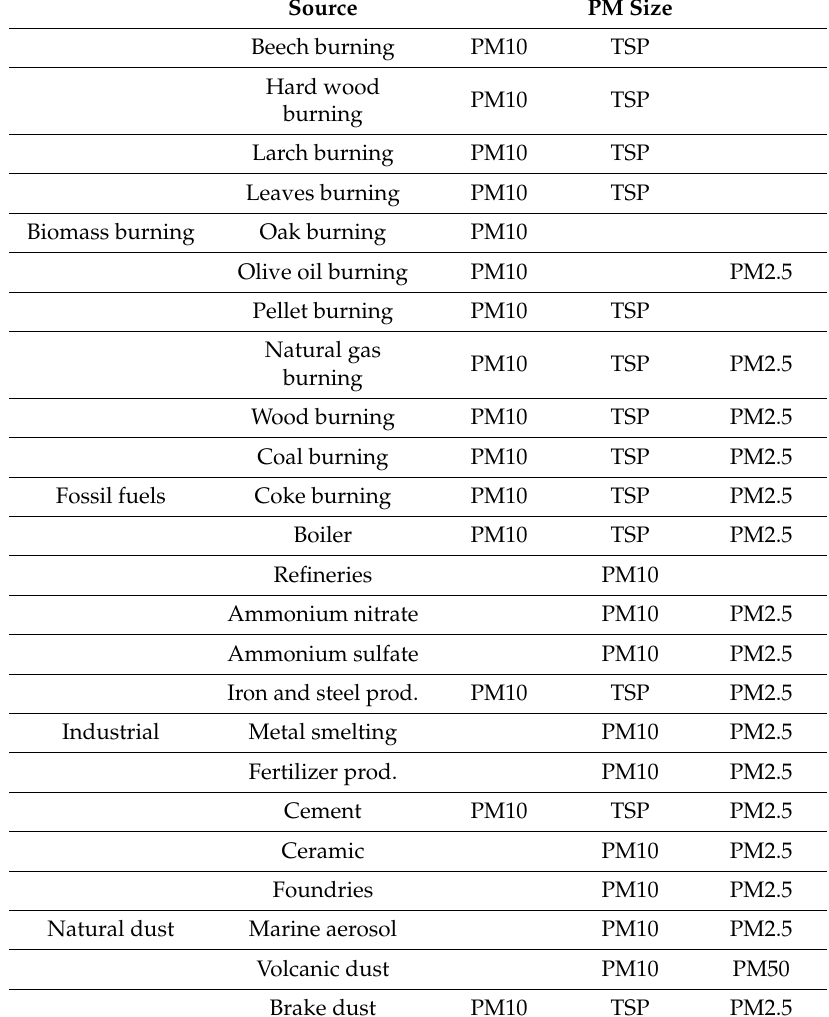
Table 3. The most common sources of PM with the types of related PM emitted. Data are adapted from [47]. Source PM Size Beech burning PM10